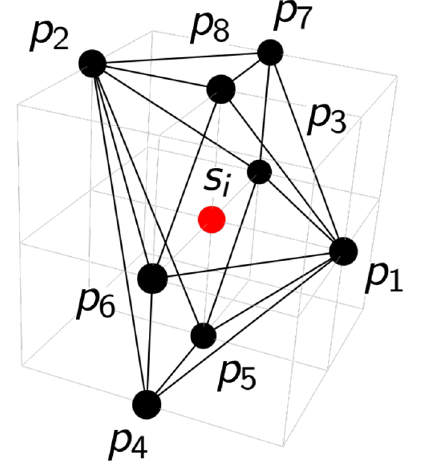
Figure 45 . Toric diagram for Model